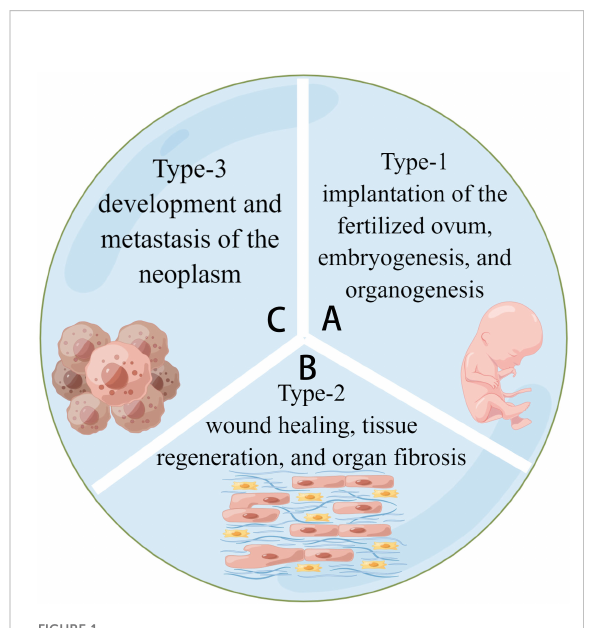
FIGURE 1 Three types of EMT. (A) Type-1 EMT is related to the embryogenesis of tissues and organs. (B) Type-2 EMT is related to tissue regeneration and fi brosis. (C) Type-3 EMT is related to tumor development and metastasis. They share a common model of cell